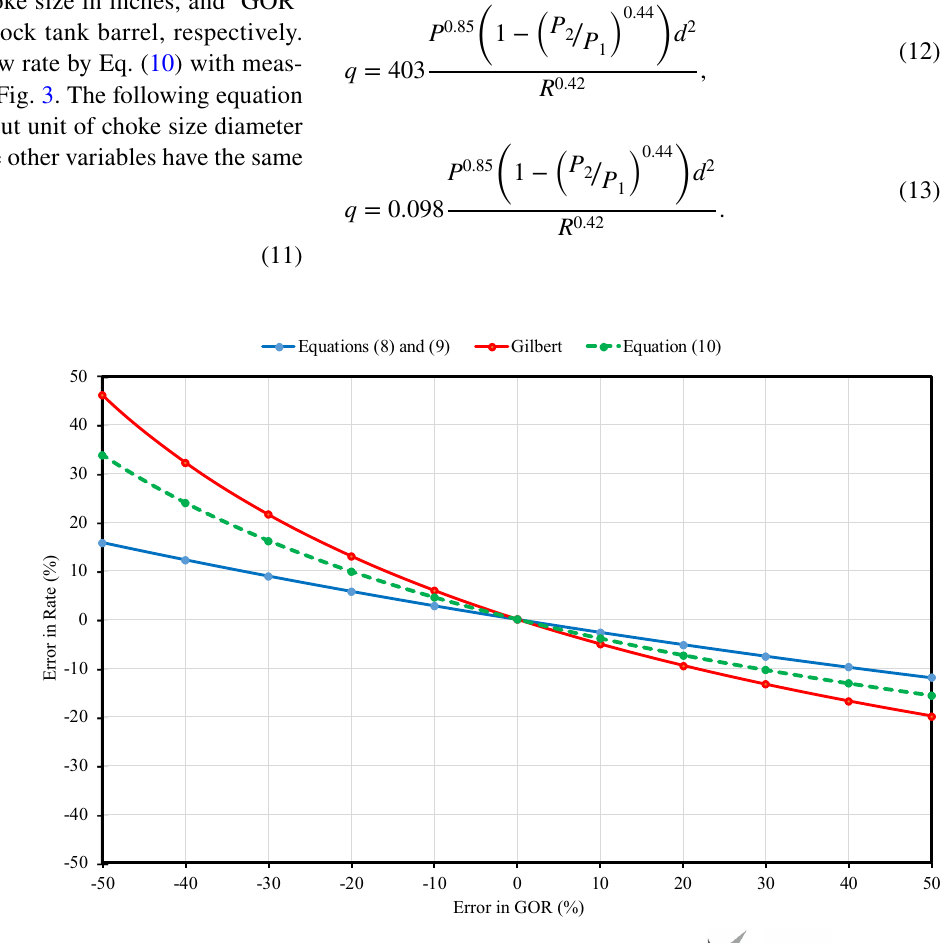
Fig. 4 Effect of error in GOR on the error in calculated